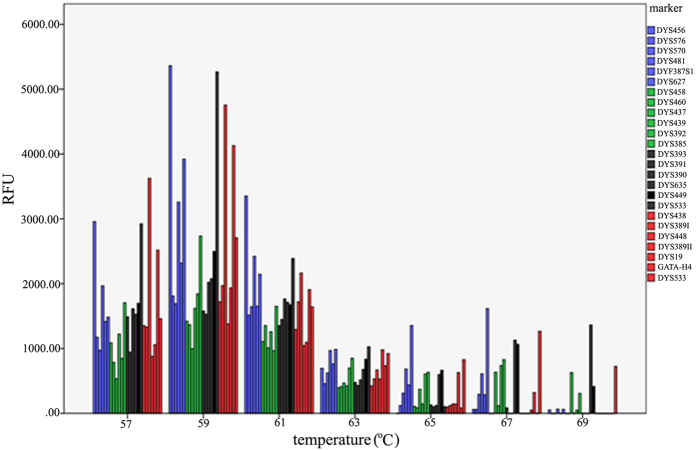
Variations of amplification efficiency at various PCR annealing temperatures.Seven annealing temperatures were tested: 57 °C, 59 °C, 61 °C, 63 °C, 65 °C, 67 °C and 69 °C. Amplification of 1 ng 9948 DNA was performed for 30 cycles on Applied Biosystems GeneAmp 9600, and 1 μl of each reaction was simultaneously analyzed on an Applied Biosystems 3130XL Genetic Analyzer with a 3 kV, 10 s injection.